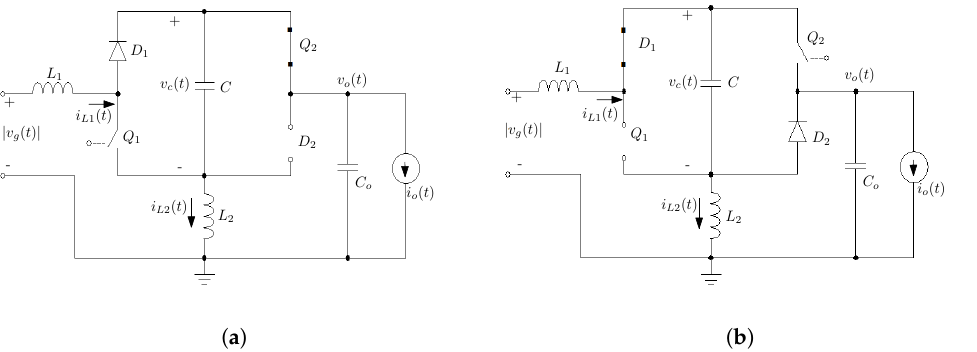
Figure 2. Simplified model for different mode: ( a ) Boost mode. ( b ) Buck